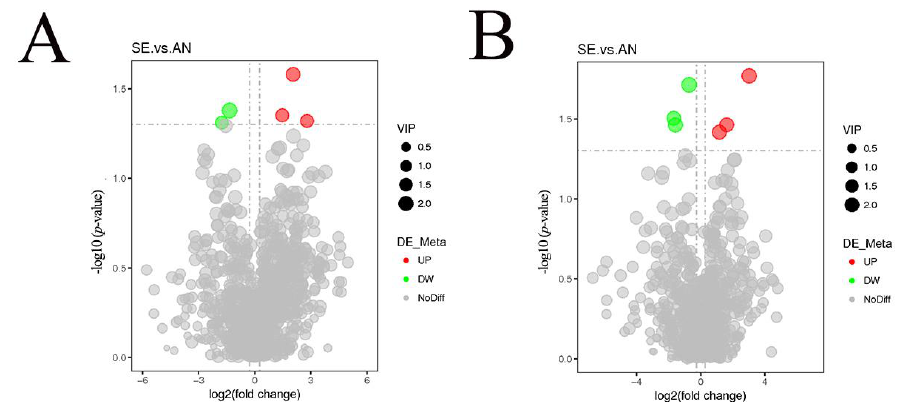
Figure 3. Volcano plot of differentially metabolites identified in positive polarity mode ( A ) and negative polarity mode ( B ).